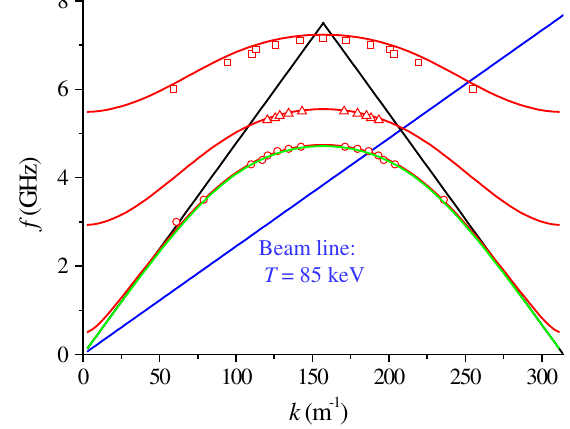
FIG. 10. The three lowest branches of the 3D dispersion rela- tion for the grating without sidewalls, with q chosen to yield the correct band heads, are shown in red. The 2D dispersion relation is shown in green. Black lines represent the forward and back- ward light lines, while a beam line corresponding to 85 keV is shown in blue. The intersection of the beam line with the two highest branches could generate coherent SP radiation at that frequency. For the lowest branch, the intersection takes place at a sub-SP frequency, and coherent radiation can occur only at